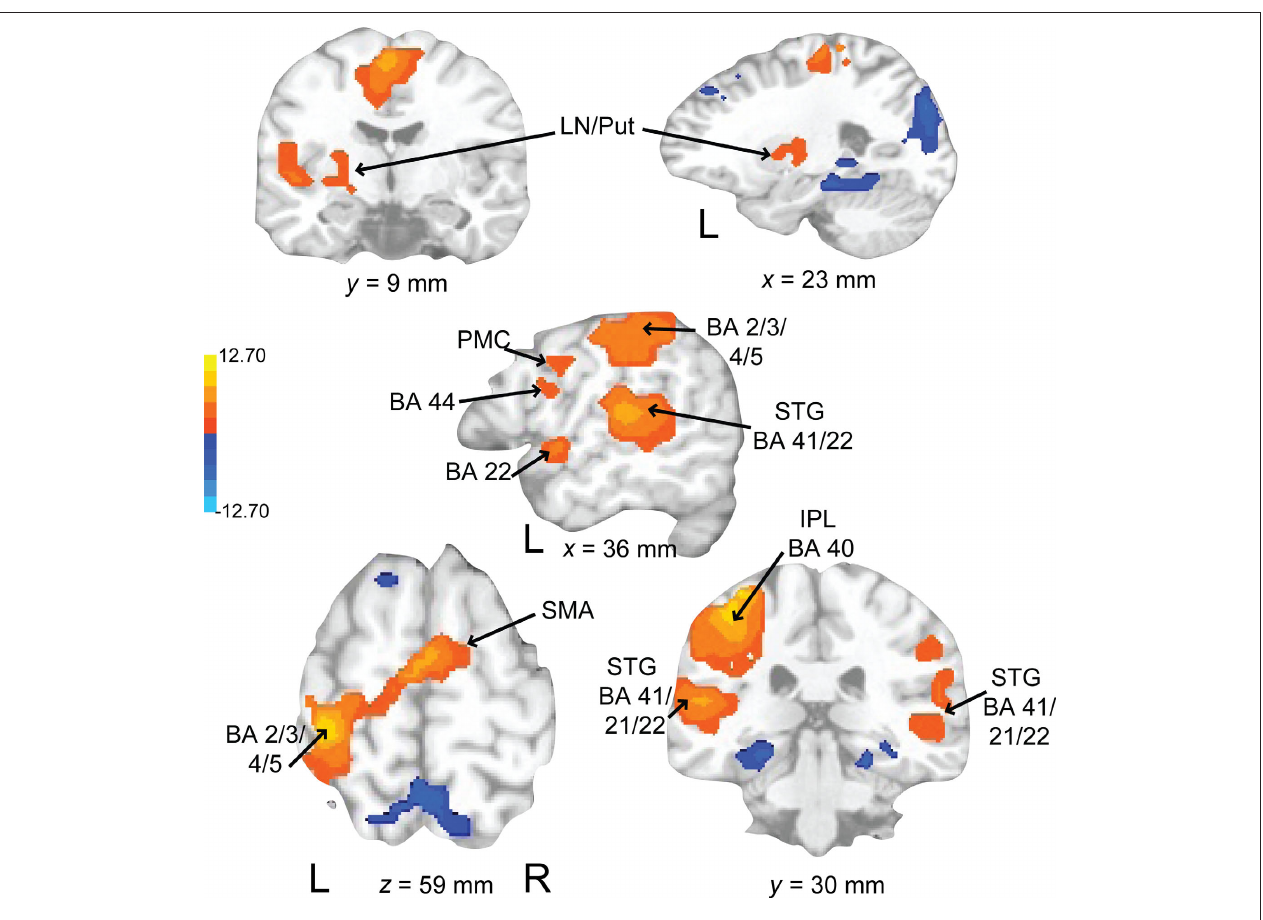
FIguRe 8 | Brain regions where BOLD signal was significantly different during the auditory reproduce condition compared to rest ( p < 0.002 corrected). Red to yellow colored voxels represent brain areas where auditory reproduce > rest. Blue areas show where auditory reproduce < rest. The axial